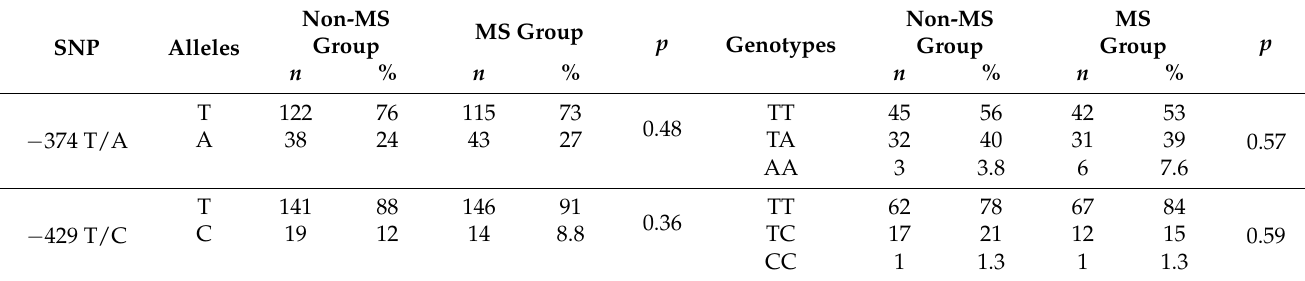
Table 2. Allelic and genotypic distributions of SNPs in the AGER gene between MS and non-MS